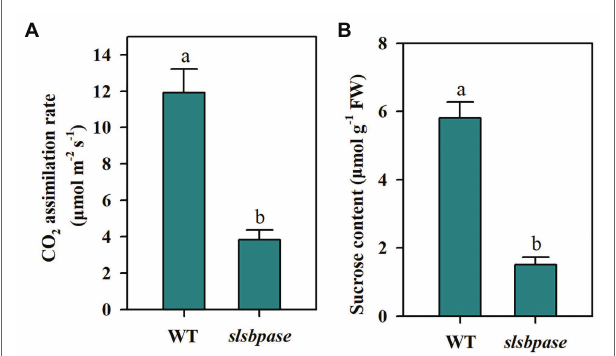
FIGURE 1 | Decreased CO 2 assimilation rate (A) and sucrose accumulation (B) as a consequence of SlSBPASE mutation in tomato T2 plants. The results are presented as mean values ± SDs from three independent experiments, and different letters on top of each column represent significantly different values at p <